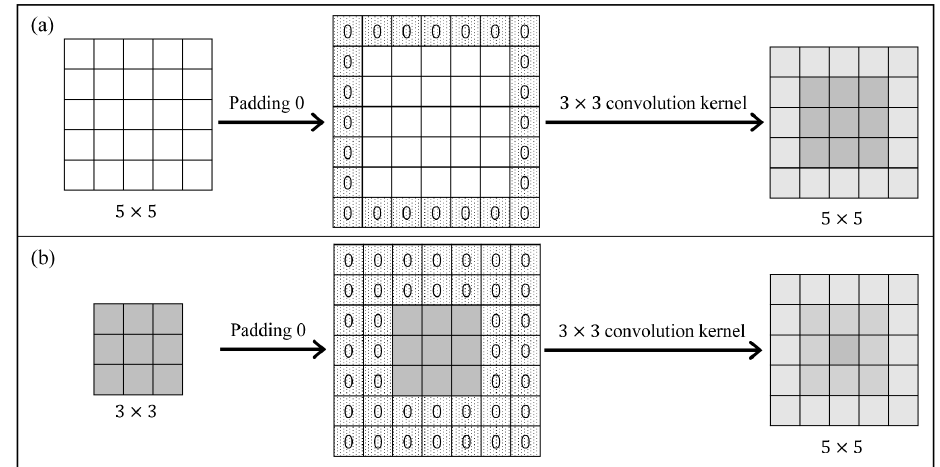
Figure 2. Illustration of ( a ) Zero Padding and ( b ) Transposed Convolution.